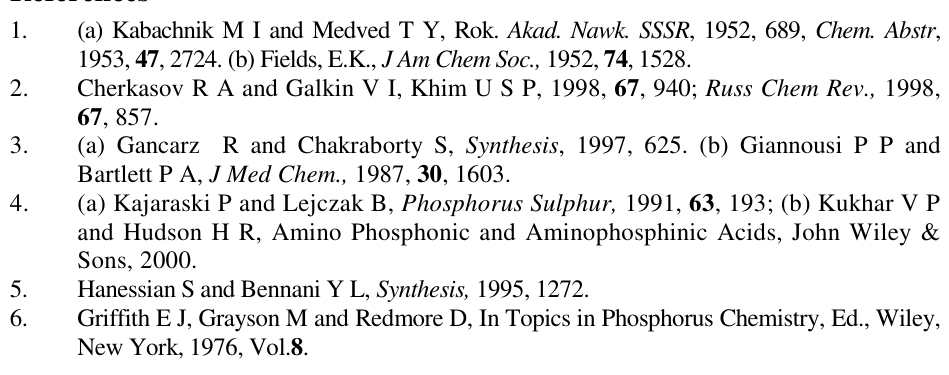
Klebsiella pneumoniae